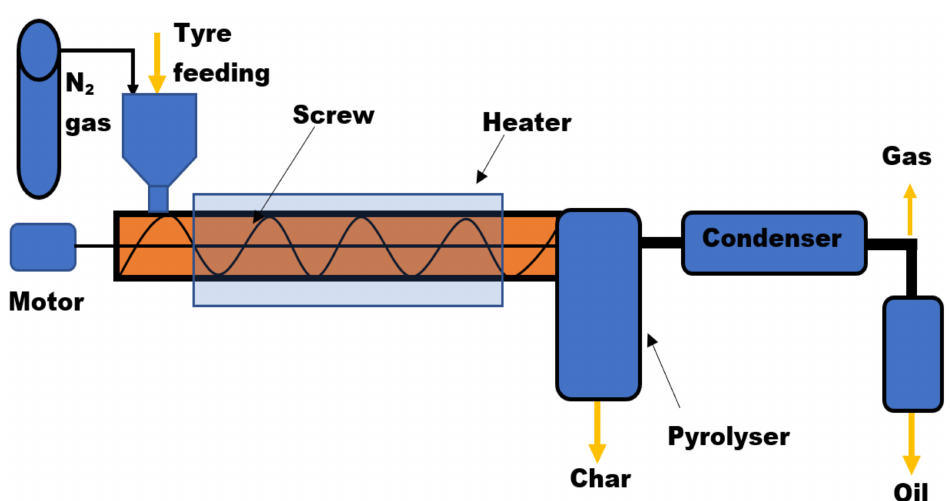
Figure 7. Diagram of a rotary screw bed pyrolysis